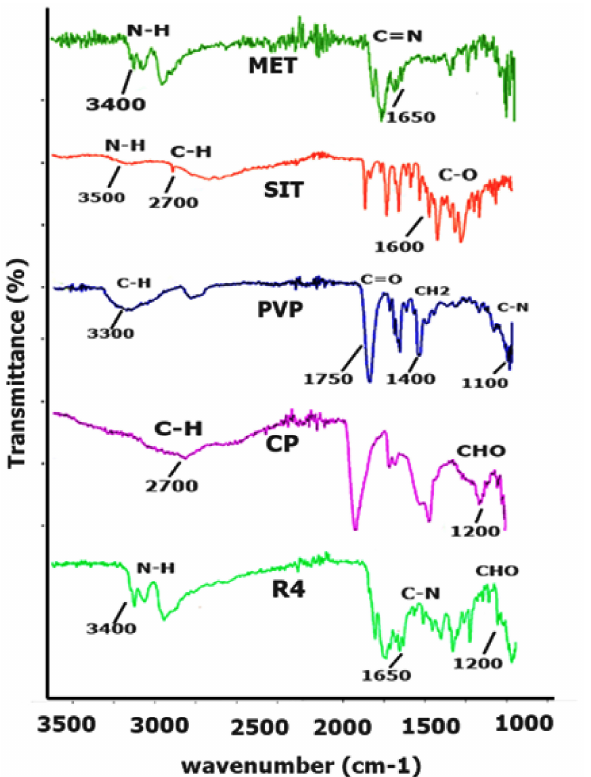
Figure 1. FTIR spectra of drugs, polymers and the physical mixture of drugs and polymers (in the ratio of the optimized formulation,